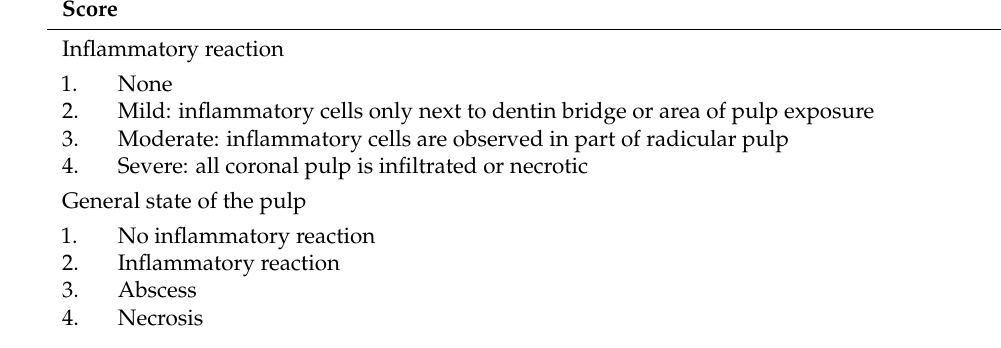
Table 1. Scoring table used for inflammation analysis, on hematoxylin and eosin-stained histological sections 15 days after pulpotomy; see representative sections in Figure 3k–o (LPS/PBS, 6/24 h of induction).